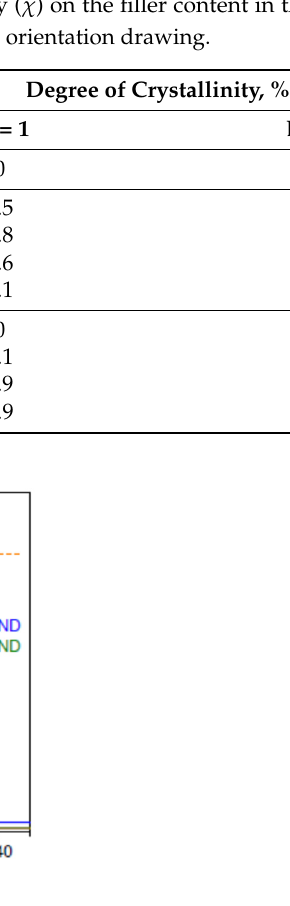
Figure 5. TGA curves of the oriented composite fibers based on HDPE.